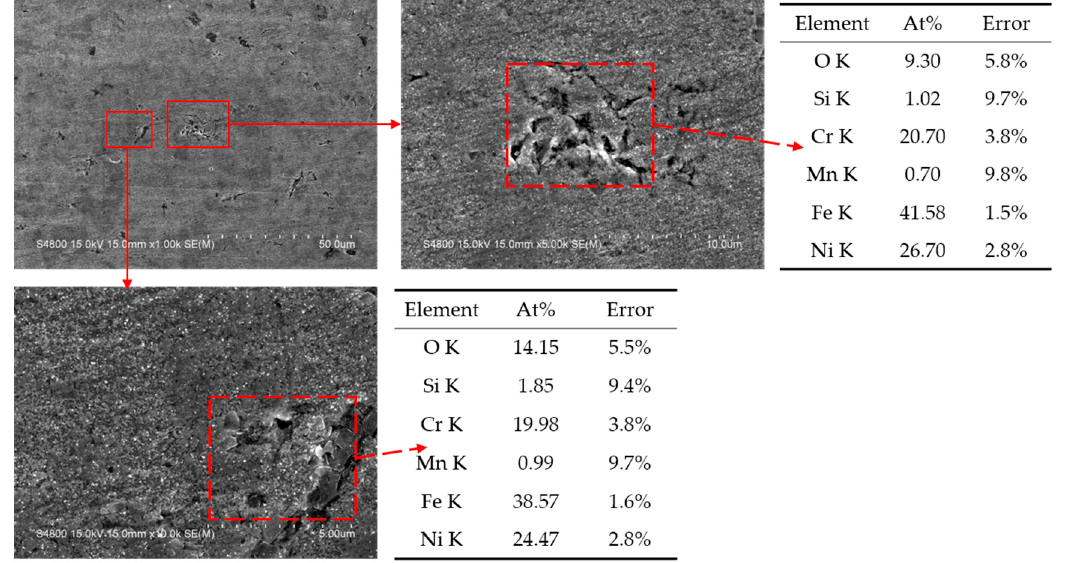
Figure 11. SEM images and the corresponding composition analysis of the passive film formed on In800 with the blank treatment.